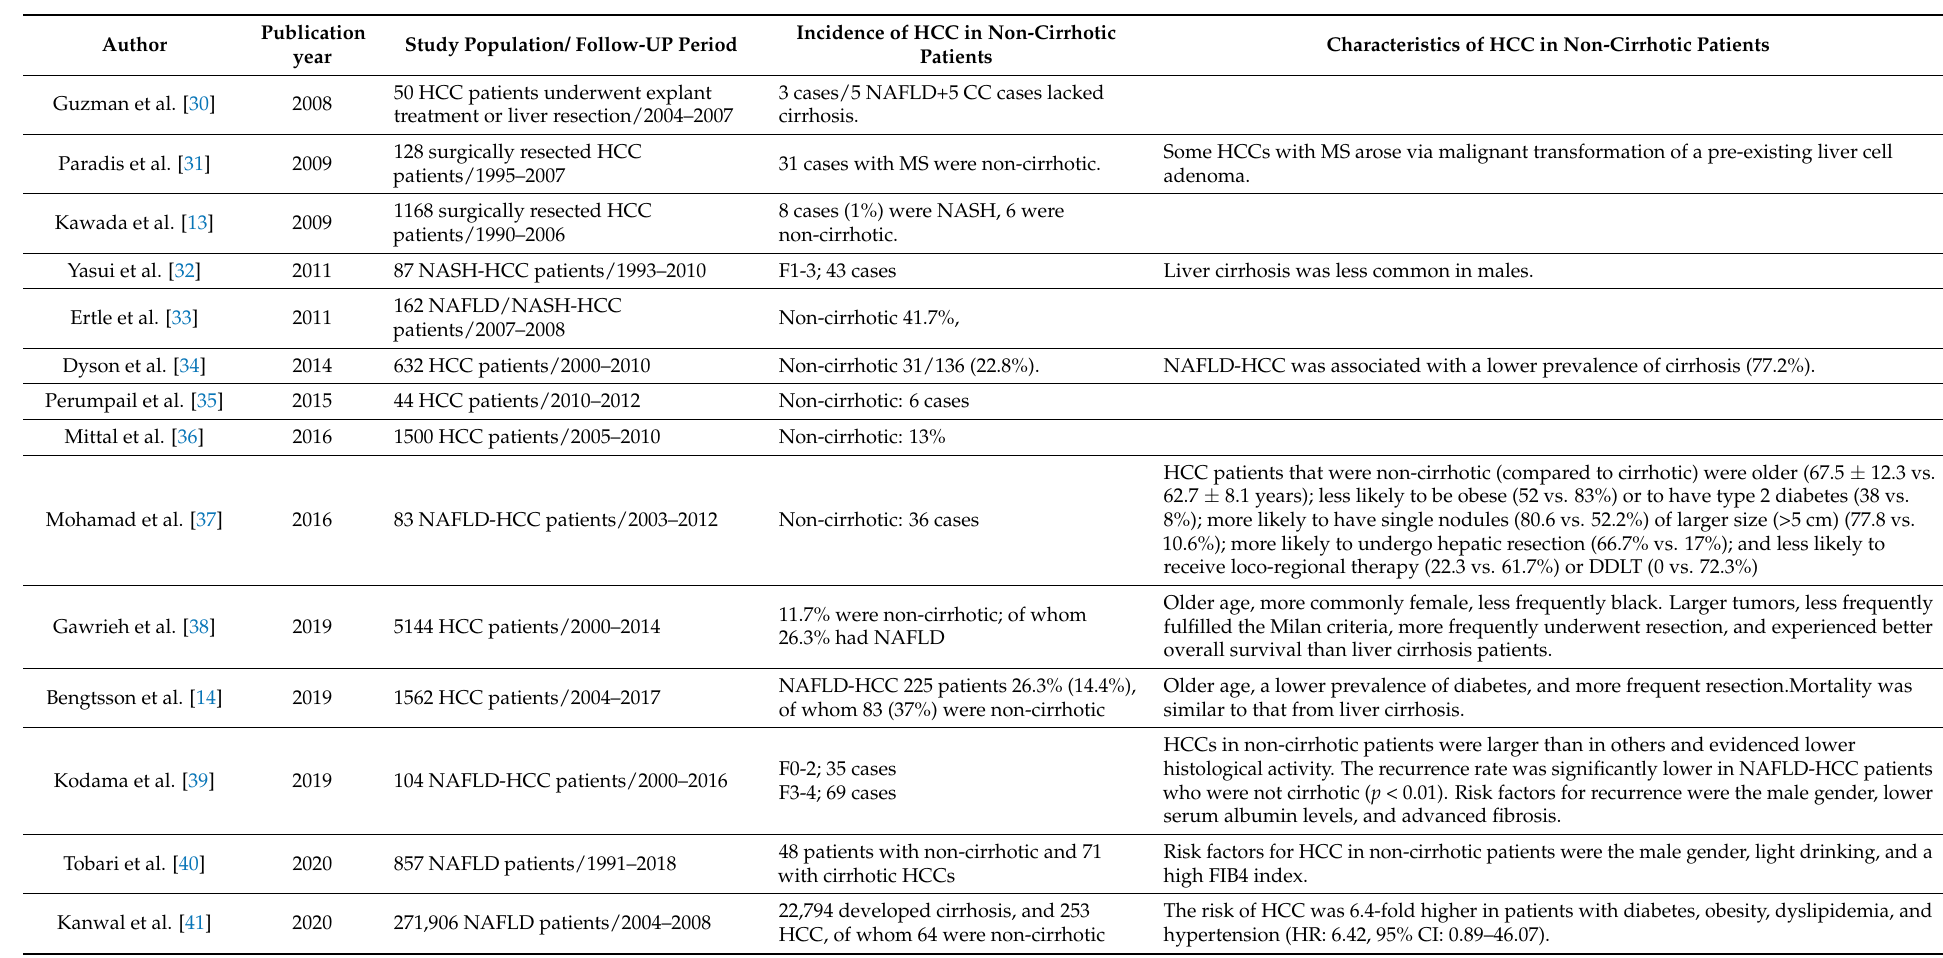
Table 1. Prevalence of NAFLD-HCC in non-cirrhotic